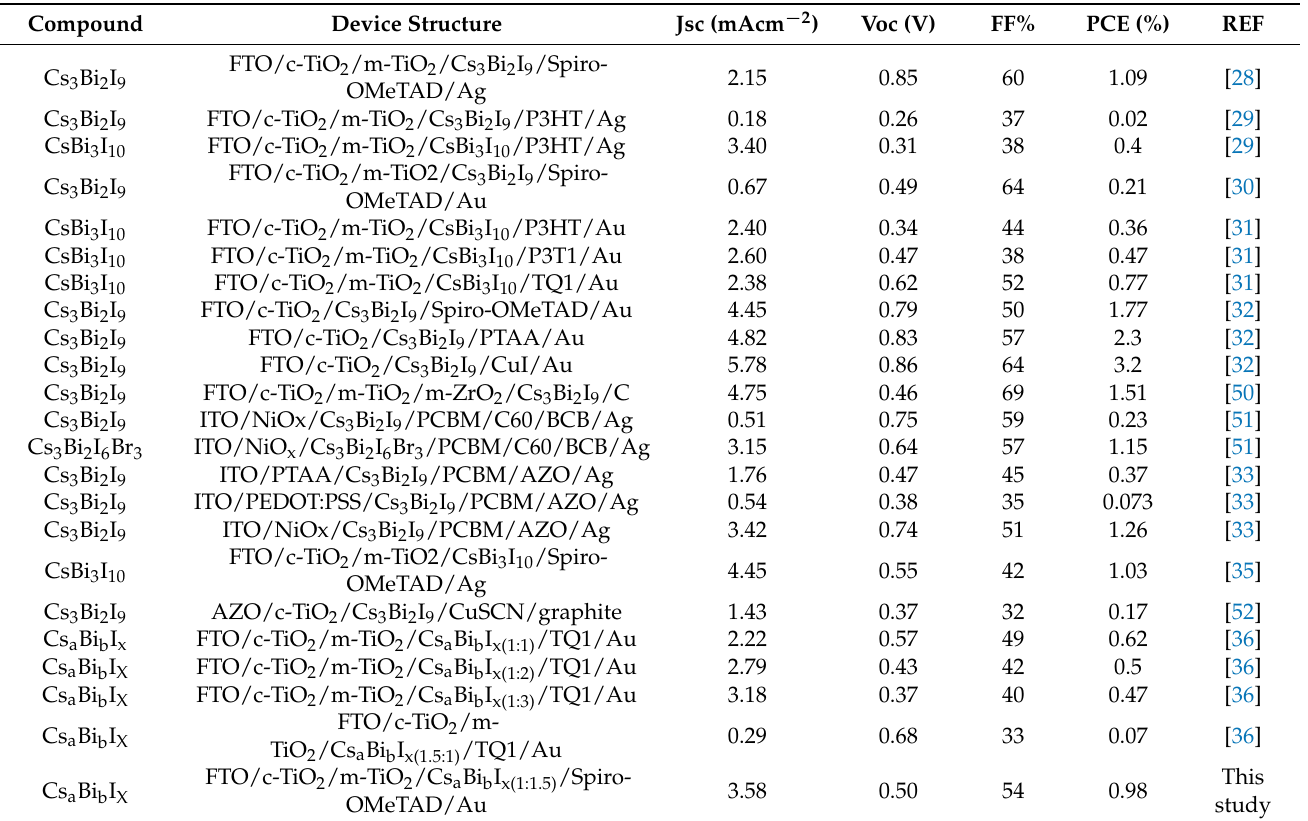
Table 2. Photovoltaic performance of lead-free bismuth-based perovskite solar cells so far fabricated. Compound Device